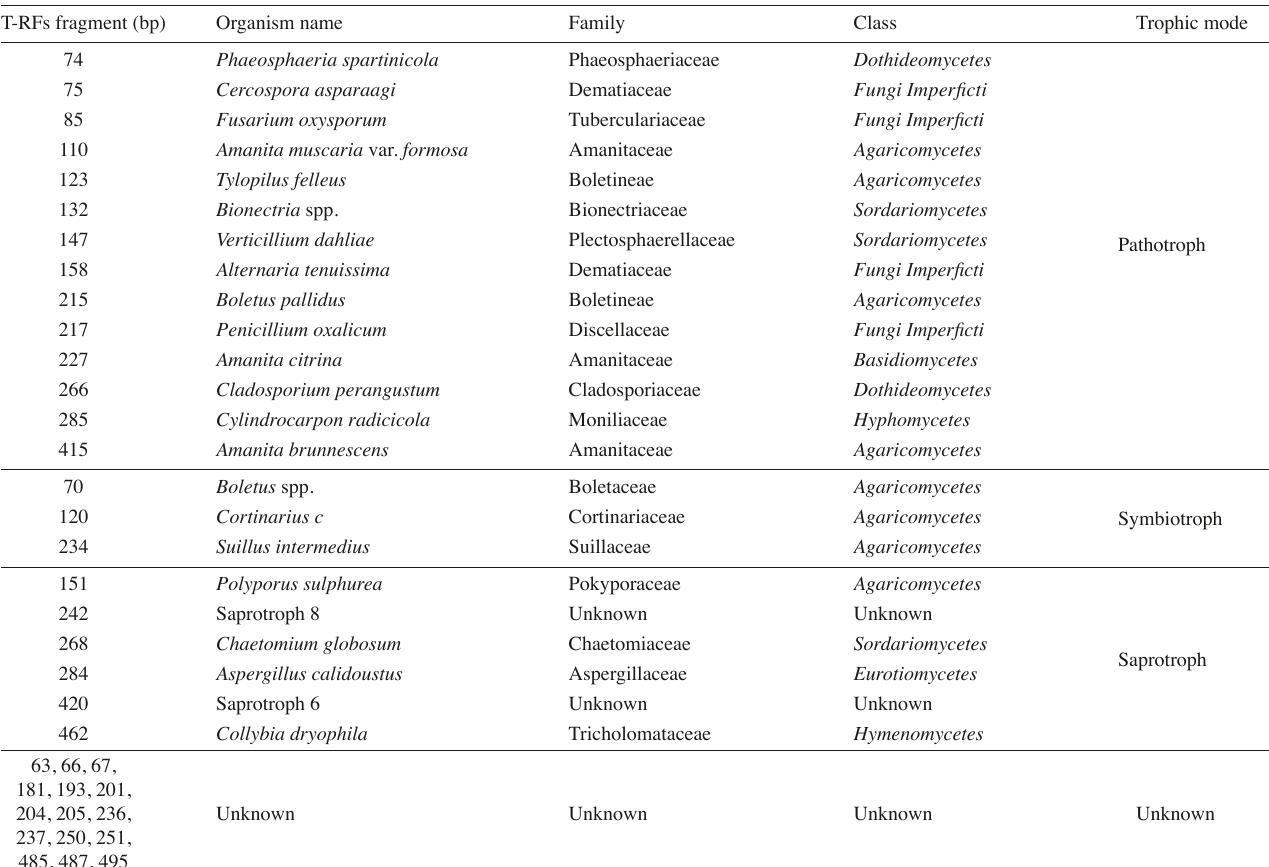
Tab. 3: The T-RFs fragments with significant correlation to soil acidity and their corresponding fungi and trophic mode. T-RFs fragment